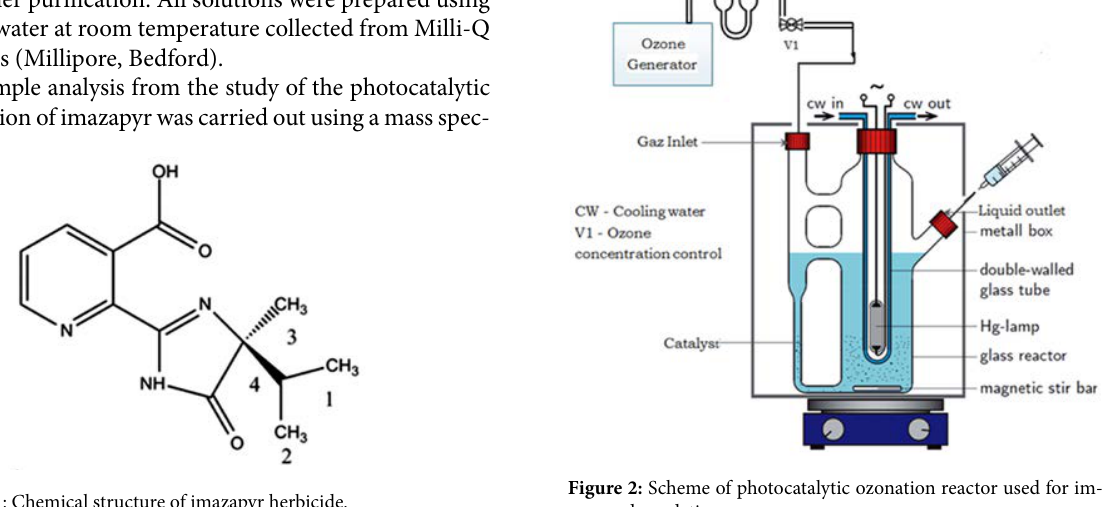
Figure 1 : Chemical structure of imazapyr herbicide.